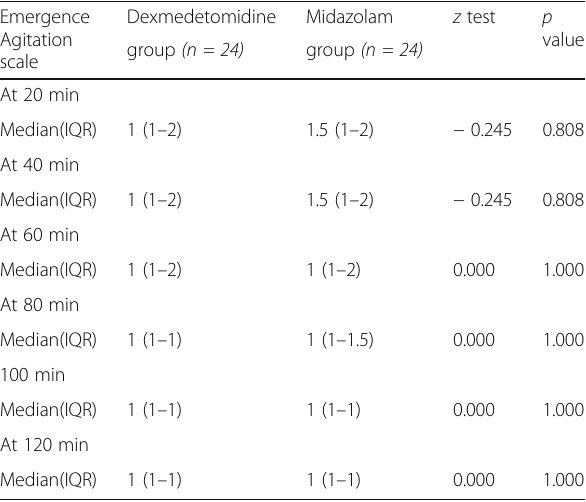
Table 12 Comparison between group D and group M